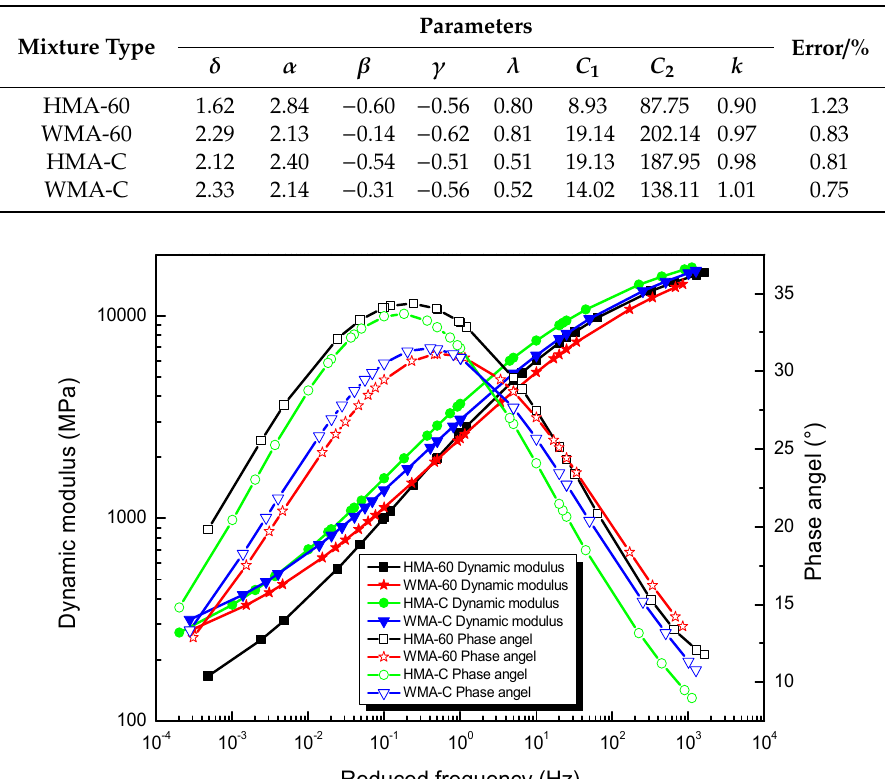
Figure 2. Master curve of dynamic modulus and phase angle.